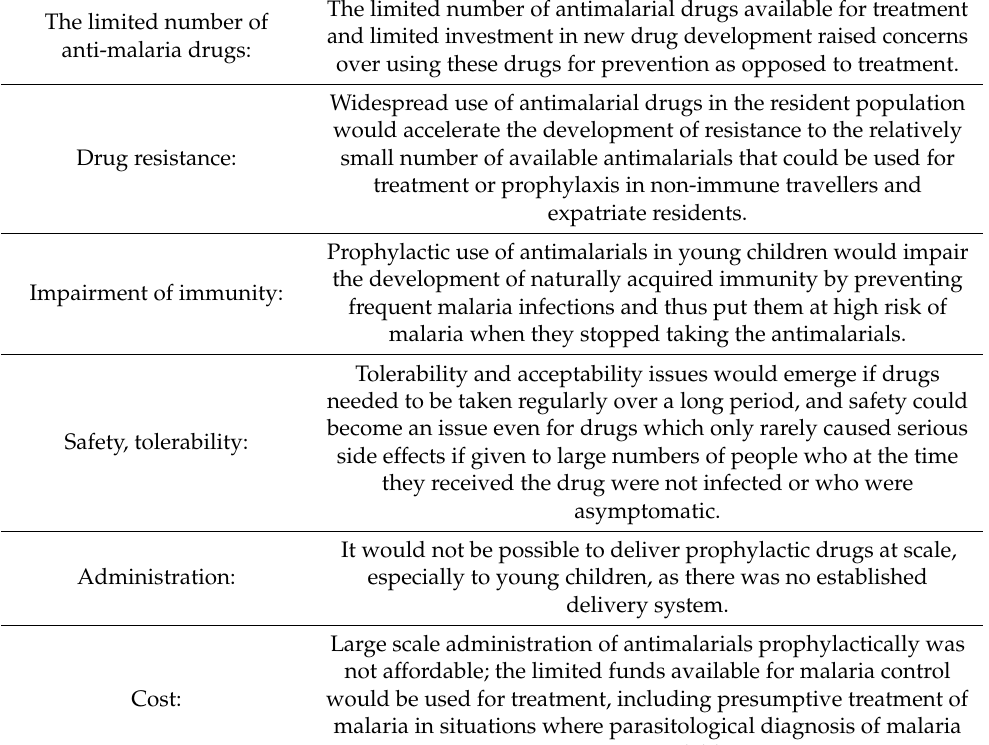
Table 1. Historic concerns expressed over the use of chemoprevention in the resident population of malaria endemic